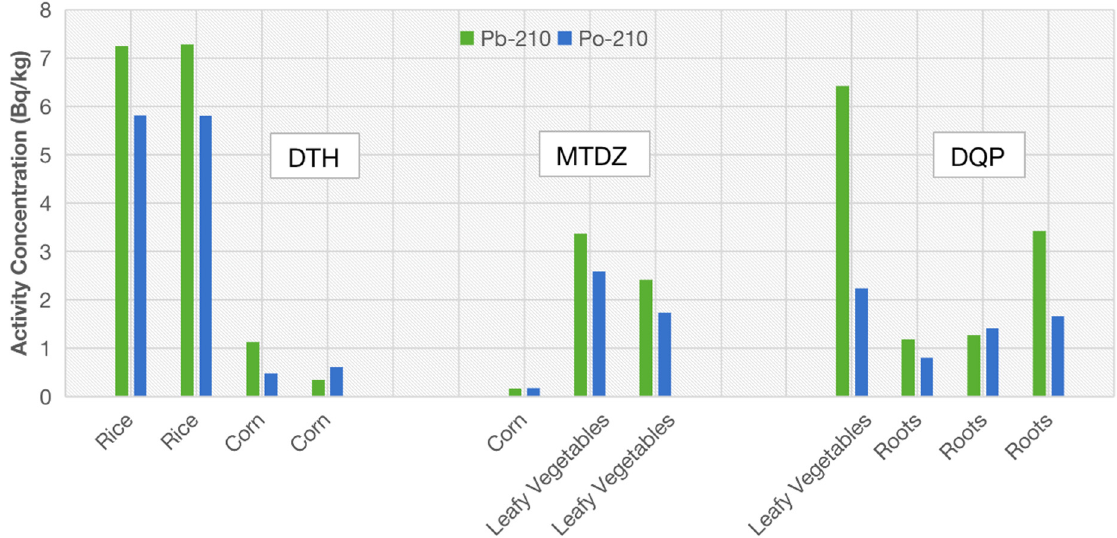
Figure 4. The radionuclide concentrations in different types of crops in 3 villages.